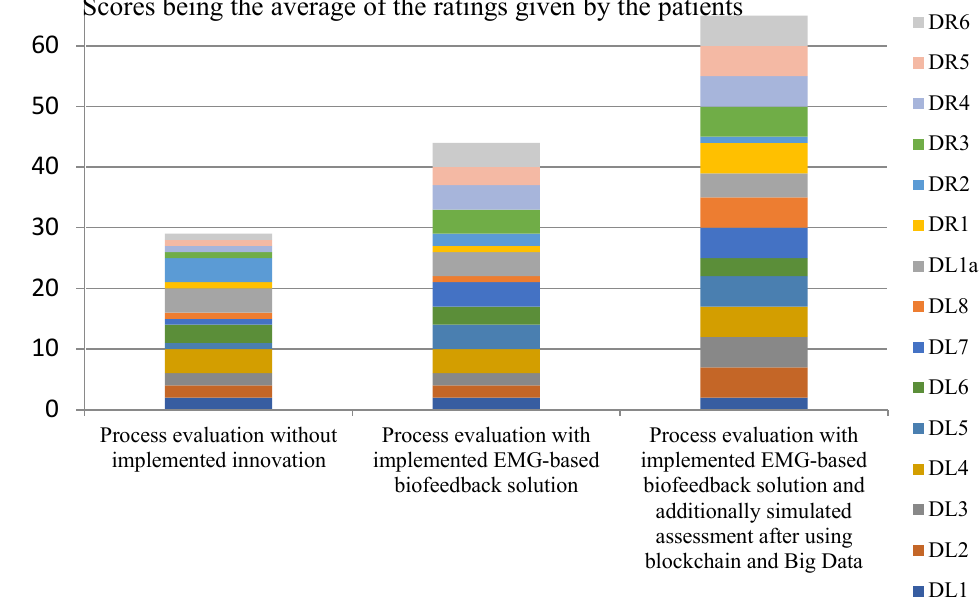
Figure 3. Assessments of the process steps in terms of the creation of values for the patient’s mental health. Source: Authors’ own elaboration based on primary studies.